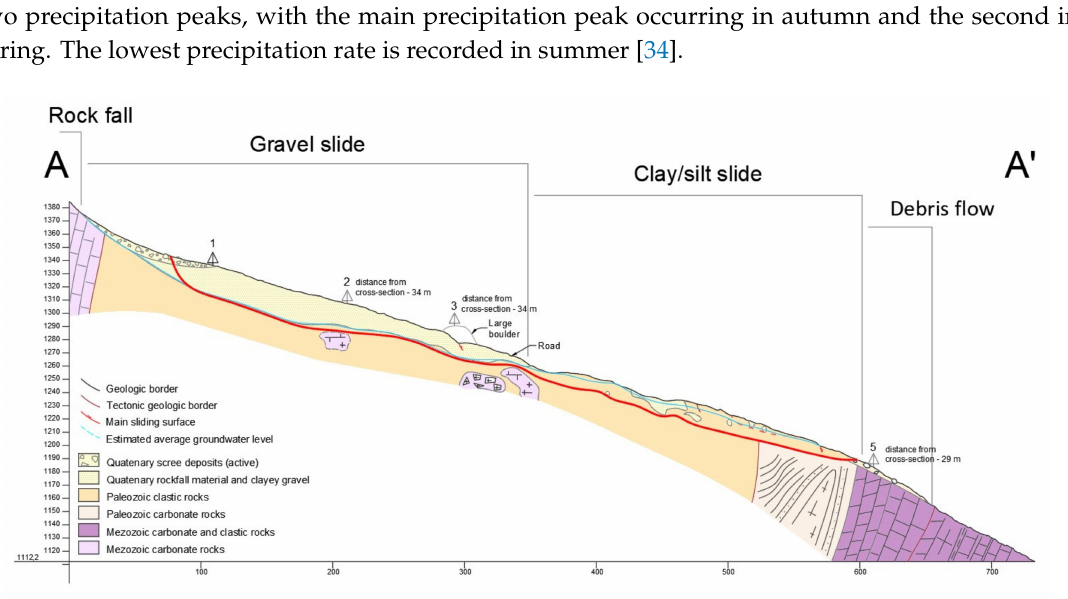
Figure 2. A cross-section of the Urbas landslide and landslide movement types according to Hungr et al.